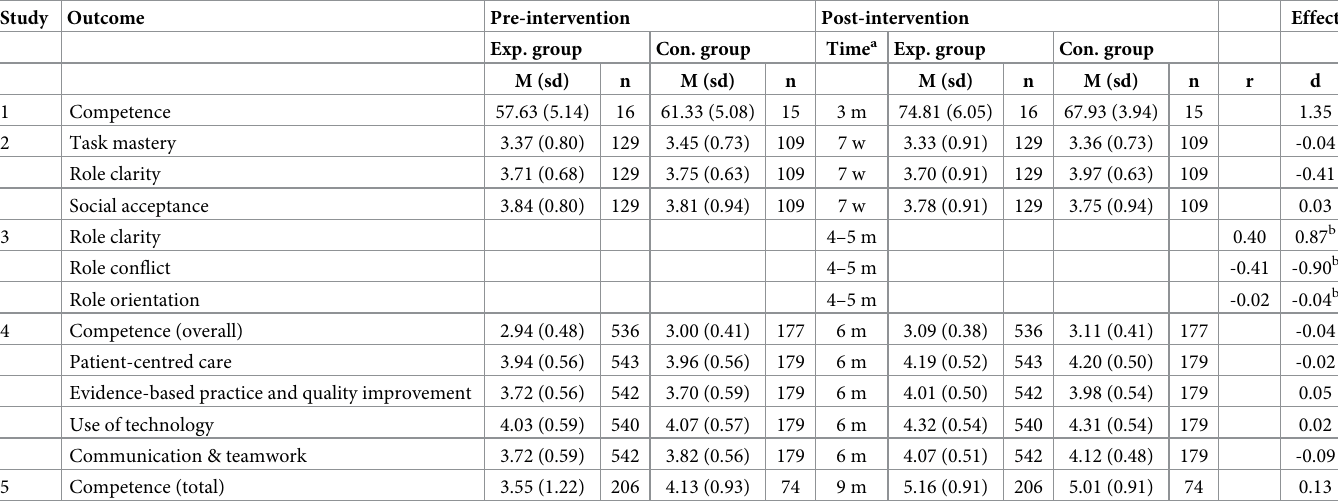
Table 3. Results of included studies and computed effect